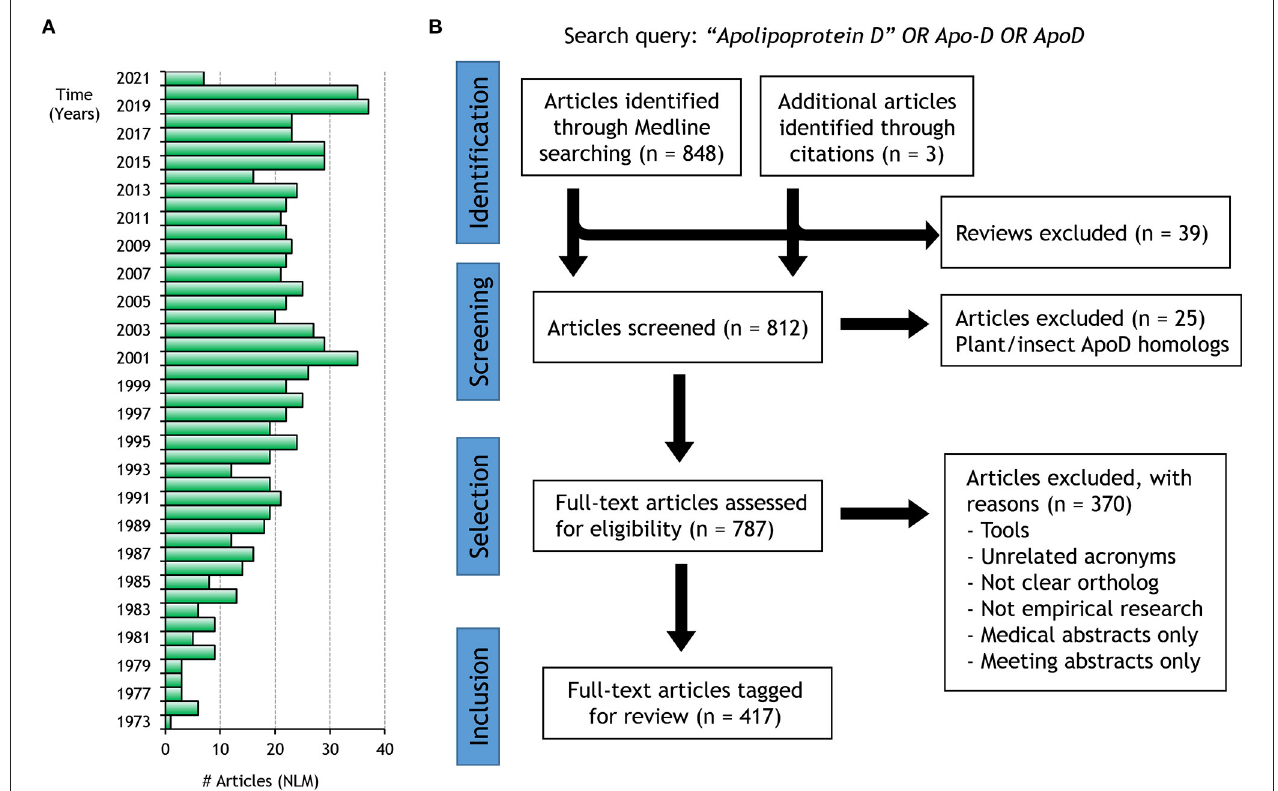
FIGURE 1 | ApoD literature search and inclusion criteria. (A) Yearly timeline of articles recovered by PubMed using the search query designed for our review. (B) PRISMA flow diagram for record inclusion in our review.